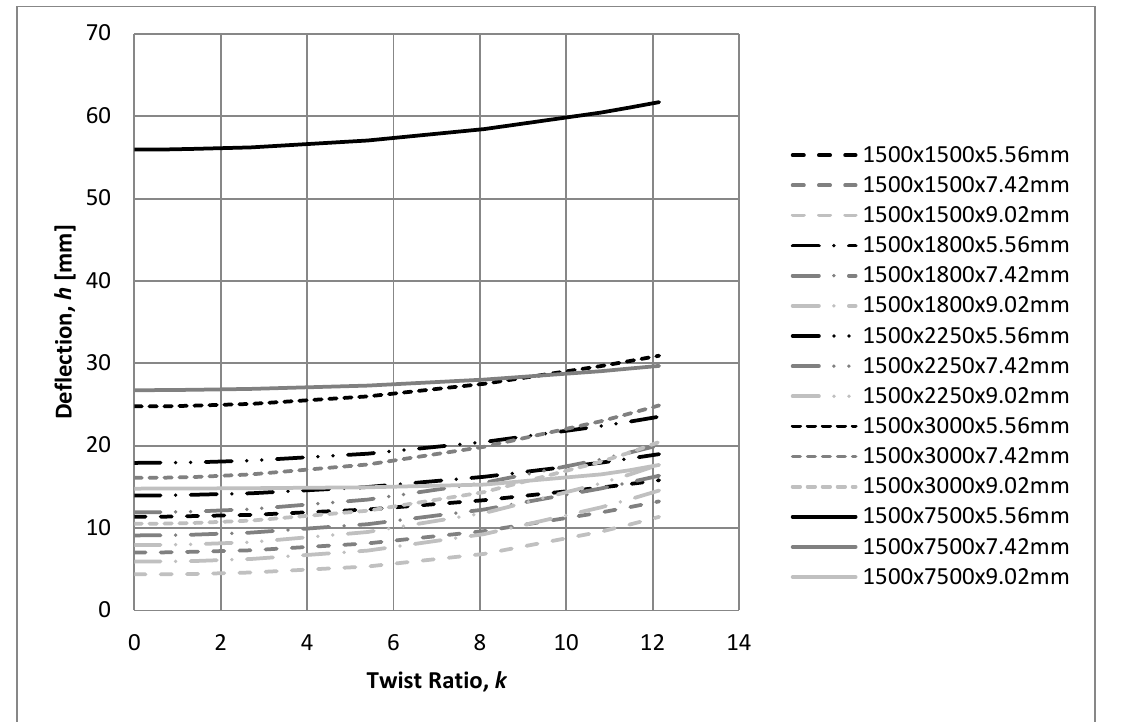
Fig. 8 Transverse deflection of 1500mm wide specimens at 1.0 kPa